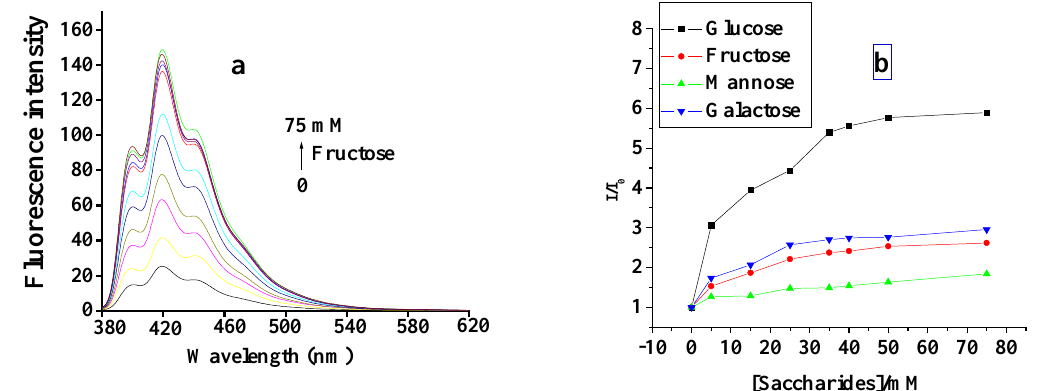
Table 1 The association constants (K fluorescence intensity enhancement ( I / I